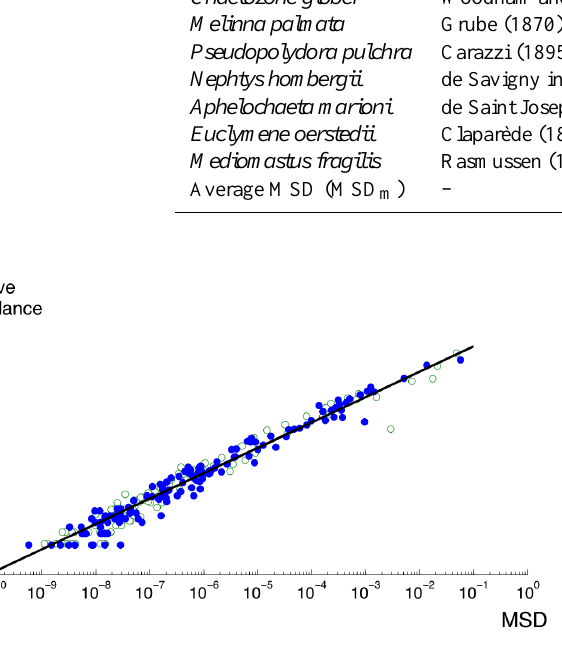
Fig. 5. MSD as a function of polychaete species mean relative abundance. Species with high MSD values are the most abundant in the communities; conversely rare species have low MSD. Equation of the fit: MSD = 0 . 2 <r > 1 . 5